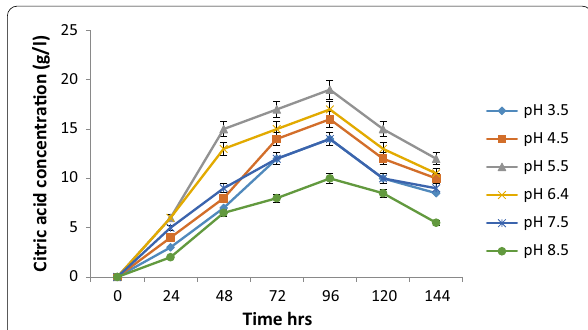
Fig. 4 Effect of initial pH on citric acid production from wild cocoyam